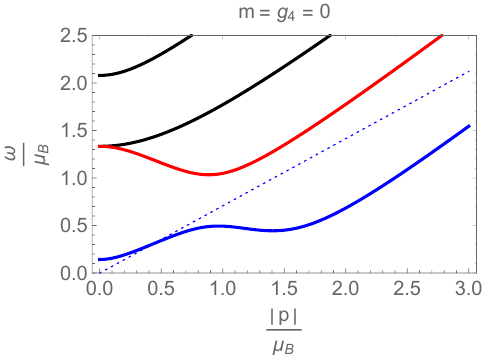
Figure 7 . The semiclassical spectrum of the U(2) ’ SU(2) (cid:2) U(1) theory. All states are gapped. Nevertheless, the lightest state displays a roton-like minimum. The dotted blue line passing through p the origin with slope 1 2 is shown to emphasize the absence of phonon-like linear